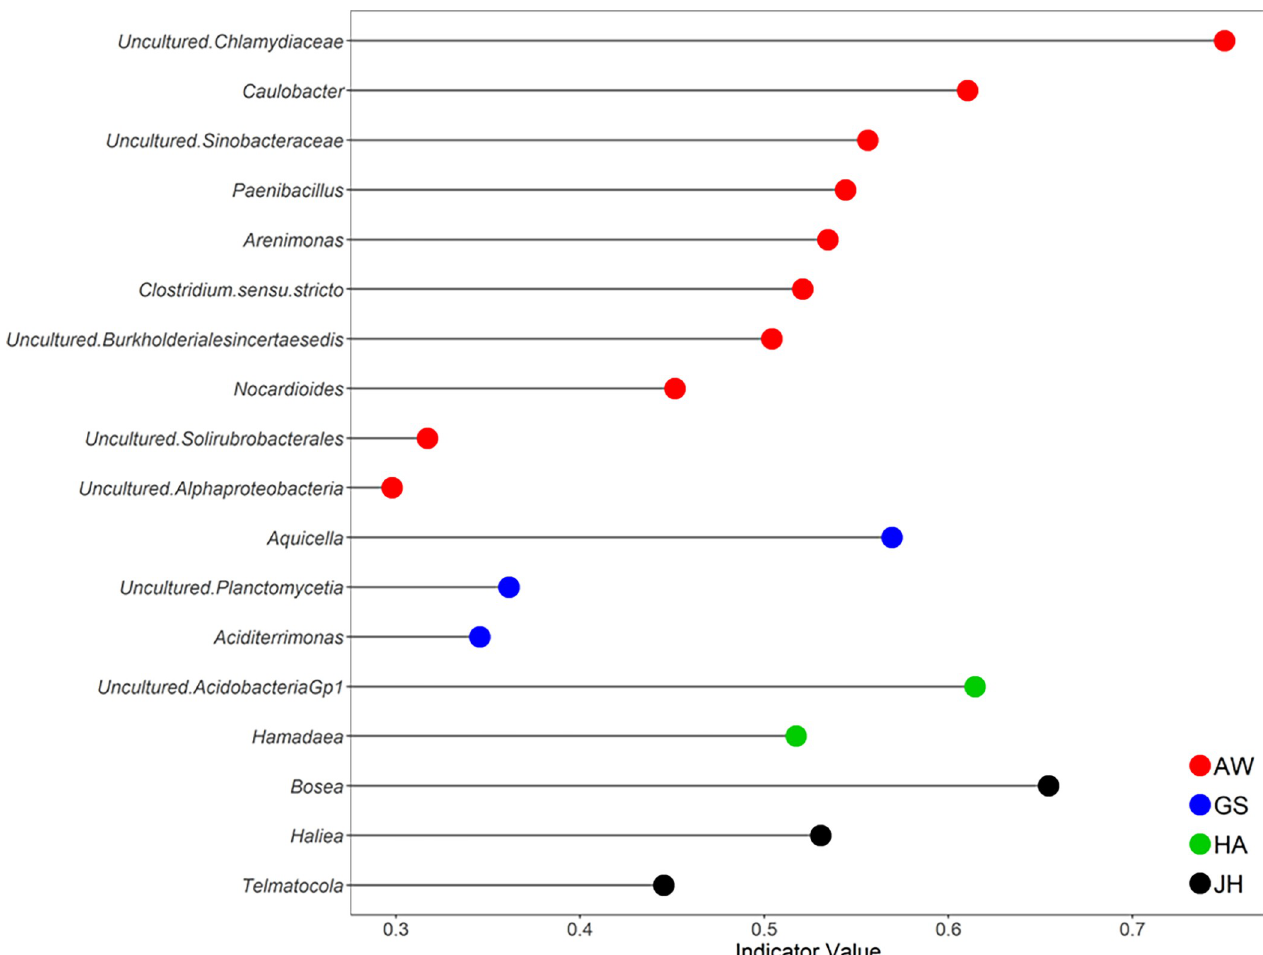
Fig 4. Indicator species analysis (ISA) of 16S rRNA OTUs at the genus level. The most characteristic species of the microbial community in four Gotjawal areas were identified through the indicator value using ISA.